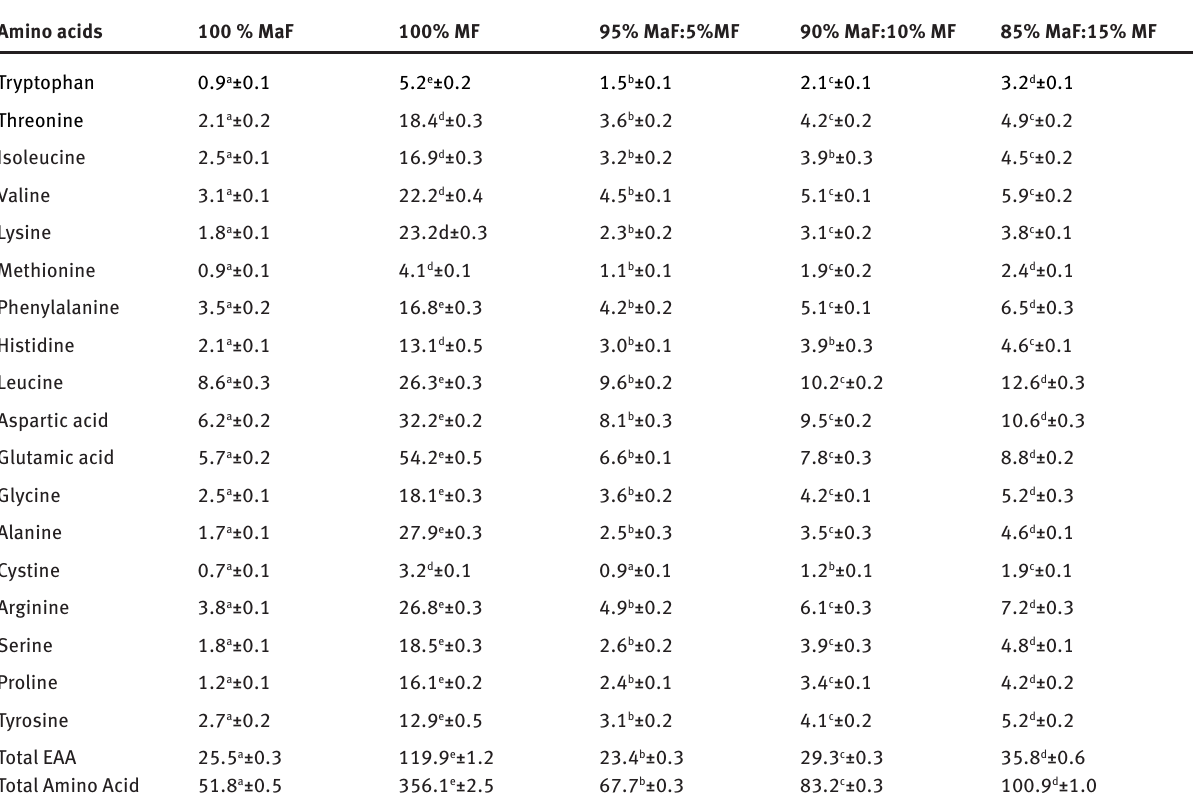
Table 4: Amino acid profile of maize ( Zea mays ) flour composited with mushroom ( Pleurotus ostreatus ) flour at different ratio (mg/g)